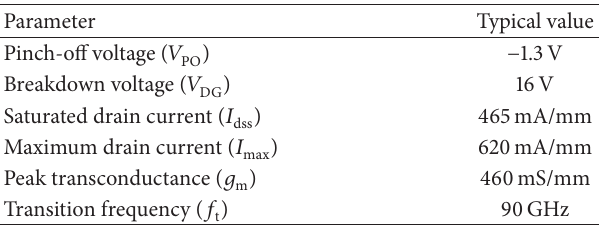
Table 1: Typical DC and RF characteristics of 0.15 𝜇 m pHEMT